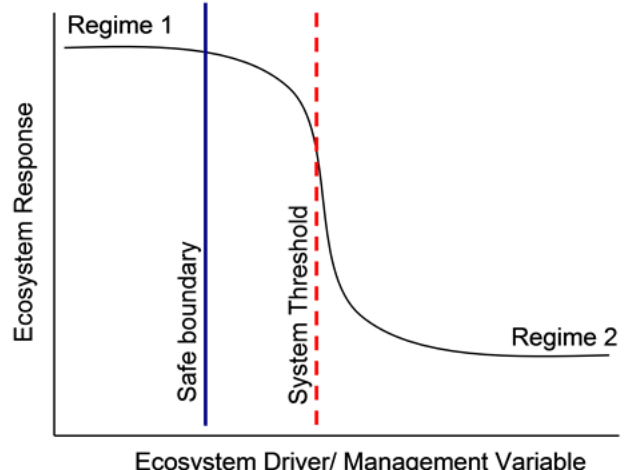
Fig. 5 . Setting safe boundaries is a common approach to dealing with system thresholds or tipping points. The distance between the boundary and the suspected system threshold will depend on factors such as the uncertainty about the threshold level, the consequences of crossing the threshold, and the inherent variability of the